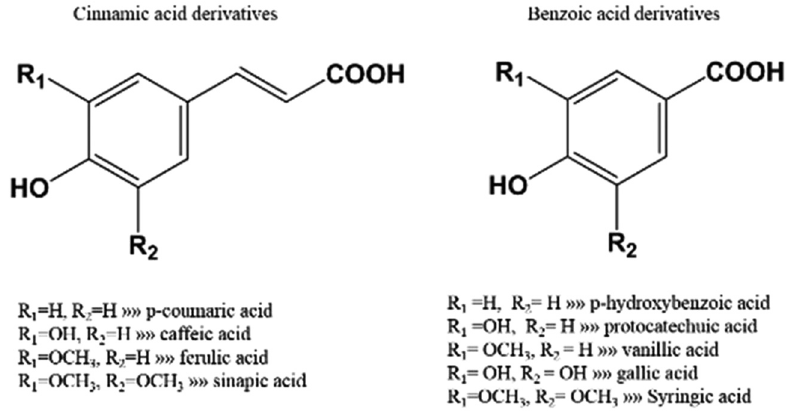
Figure 12: The phenolic acids used for the preparation of MNPs and their main chemical structures [ 170 ]